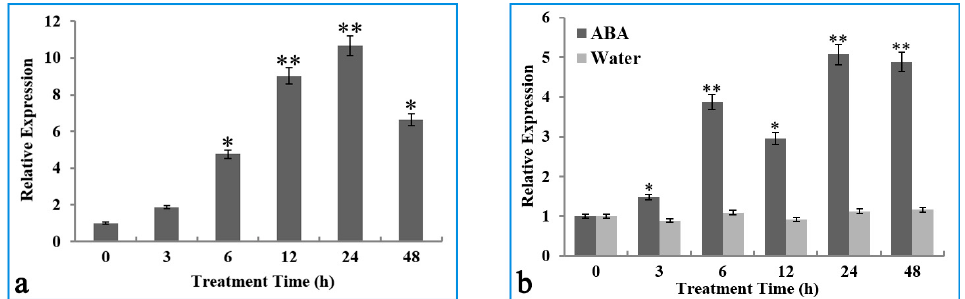
Figure 3. Quantitative reverse transcription (qRT)-PCR analysis of OsIMP gene transcript levels: ( a ) under cold stress (4 °C) and ( b ) in the presence of exogenous abscisic acid (ABA). The actin and UBQ5 genes were used as an internal reference. Data are the mean ± SE of three biological replicates, while asterisks indicate significant differences (* p < 0.05, ** p < 0.01) in comparison with control.